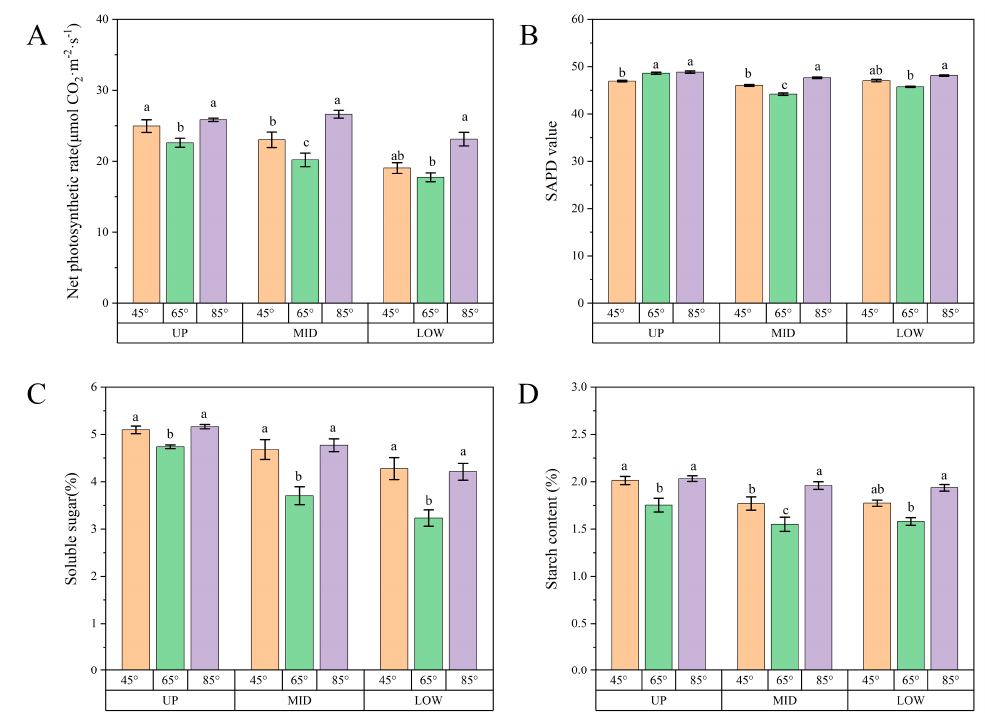
Figure 7. Photosynthetic rate and photosynthetic products of leaves in different parts of the canopy. ( A ) Net photosynthetic rate; ( B ) SPAD value; ( C ) soluble sugar; ( D ) starch content. Different lowercase letters indicate significant differences between treatments ( p < 0.05).